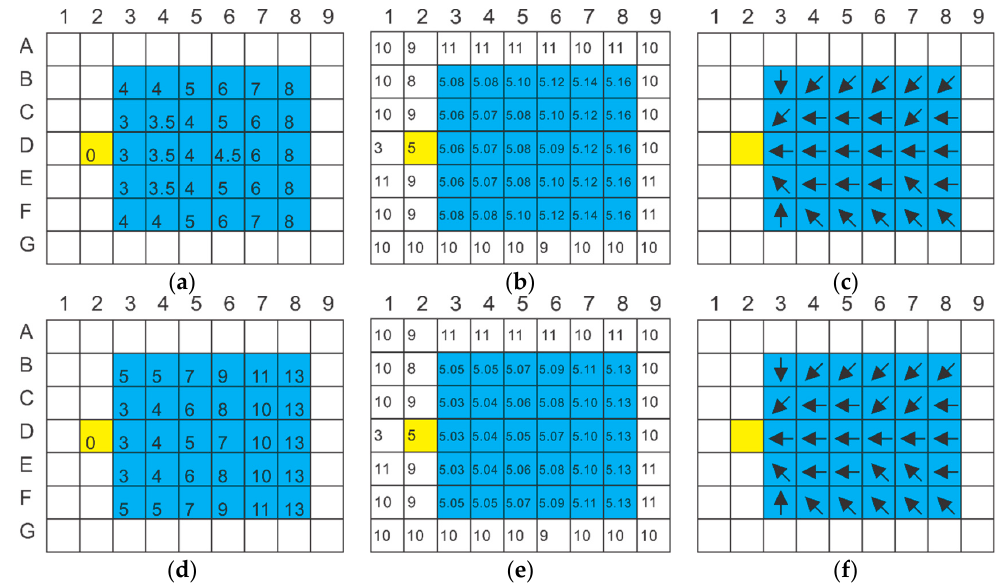
Figure 8. Final increment numbers, new elevations, and flow directions for the normal flat determined by DEDNM ( a – c ) and the new algorithm ( d – f ).